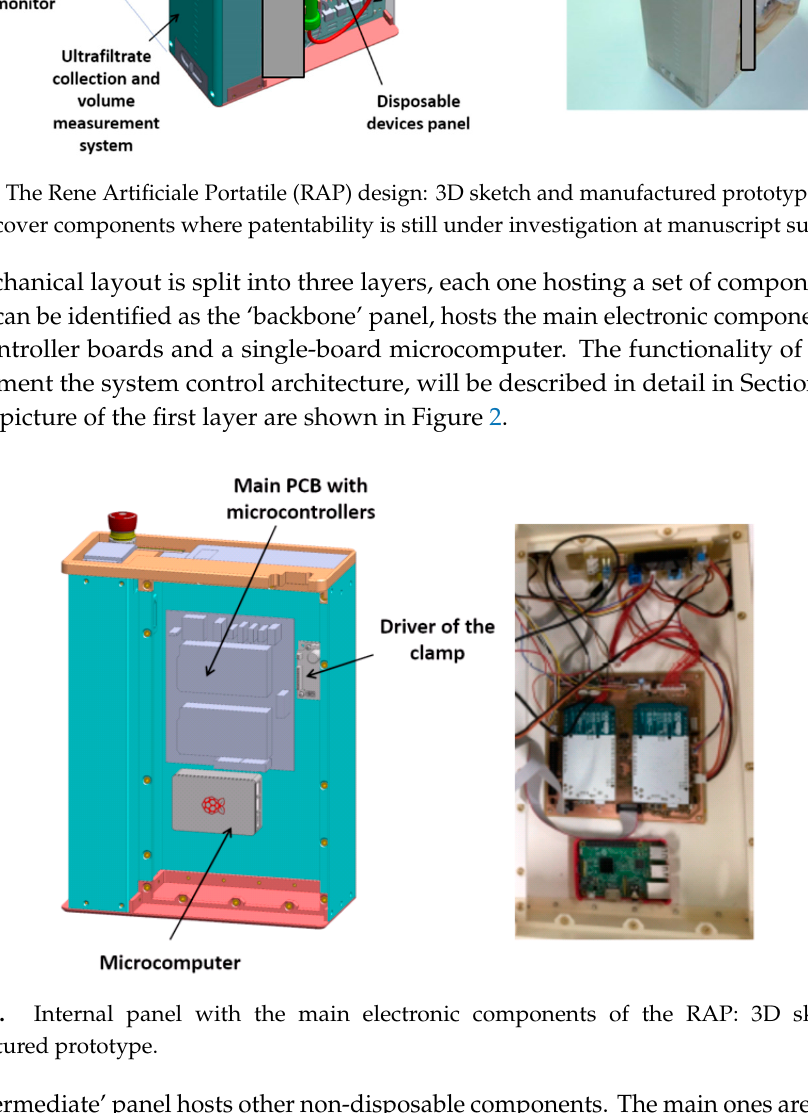
Figure 1. The Rene Artificiale Portatile (RAP) design: 3D sketch and manufactured prototype. Masked sections cover components where patentability is still under investigation at manuscript submission.